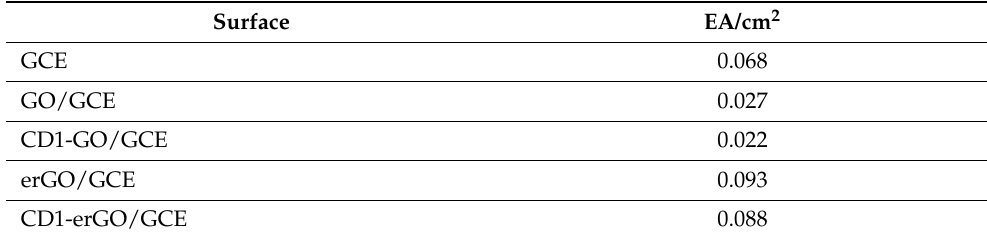
Table 1. Electrochemical area (EA) of the surfaces obtained by cyclic voltammetry with 1.0 × 10 − 3 mol/L K 3 [Fe(CN) 6 ].